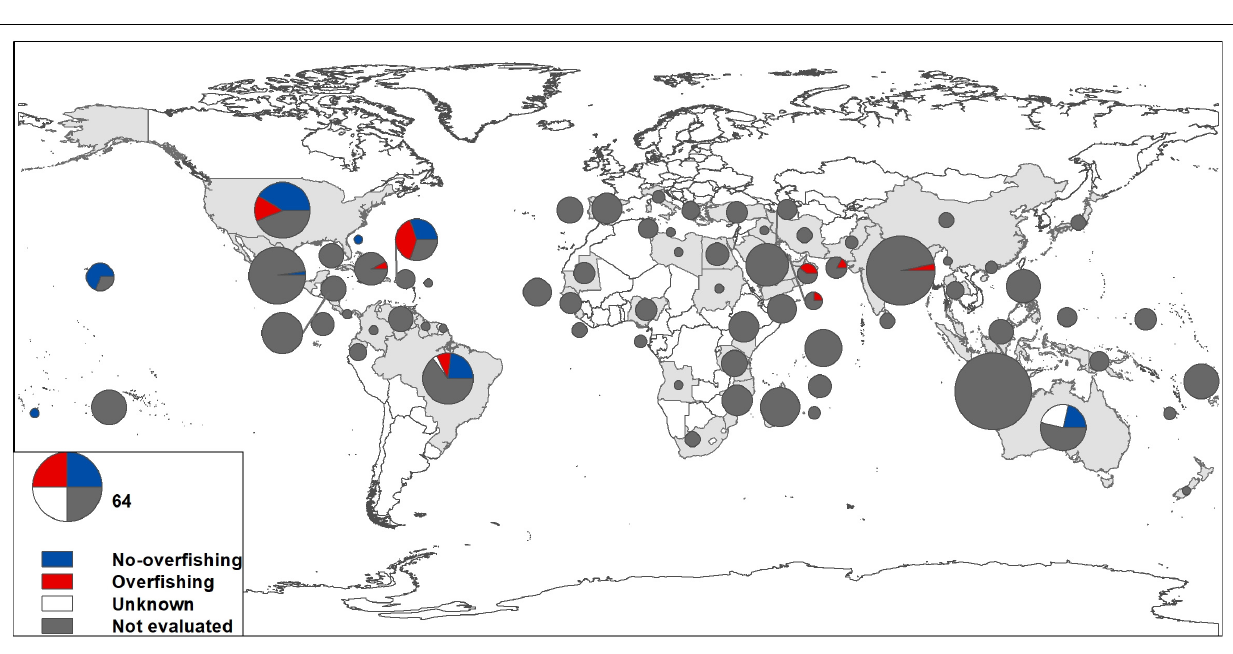
FIGURE 3 | Fishing pressure classification of snapper and grouper fisheries by country: overfishing (if a resource has been fished above the reference level, ratio > 1) and no overfishing (fishing level is below the reference level, ratio < 1). The shaded countries are those considered in this study, and the sizes of the pie charts are proportional to the number of fisheries by country included in the